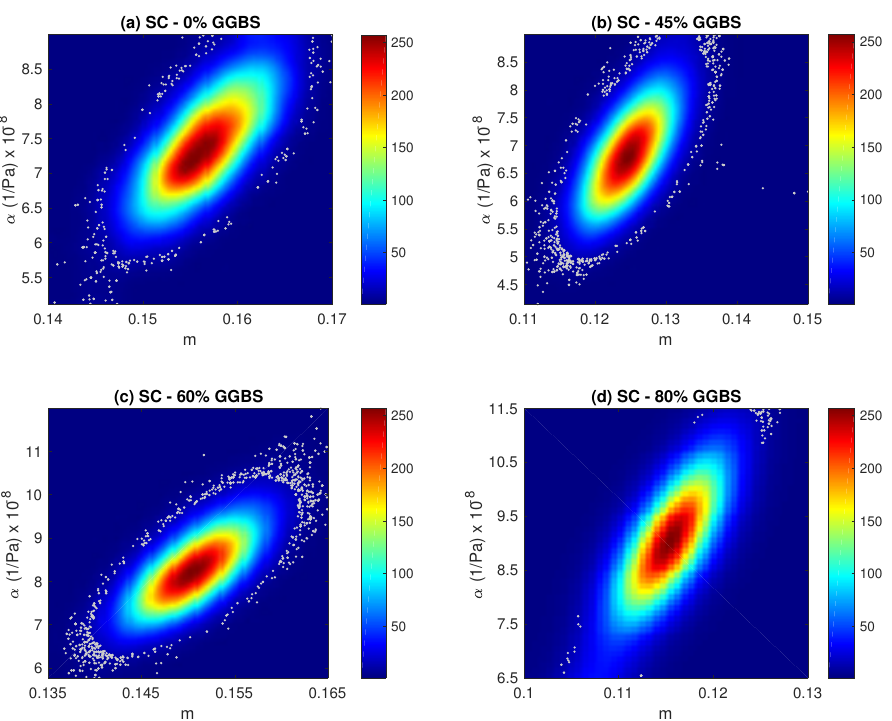
Figure 6. Two-dimensional joint posterior probability density functions of m and α resulting from the MCMC simulation. Estimates are shown for samples cured in standard condition.